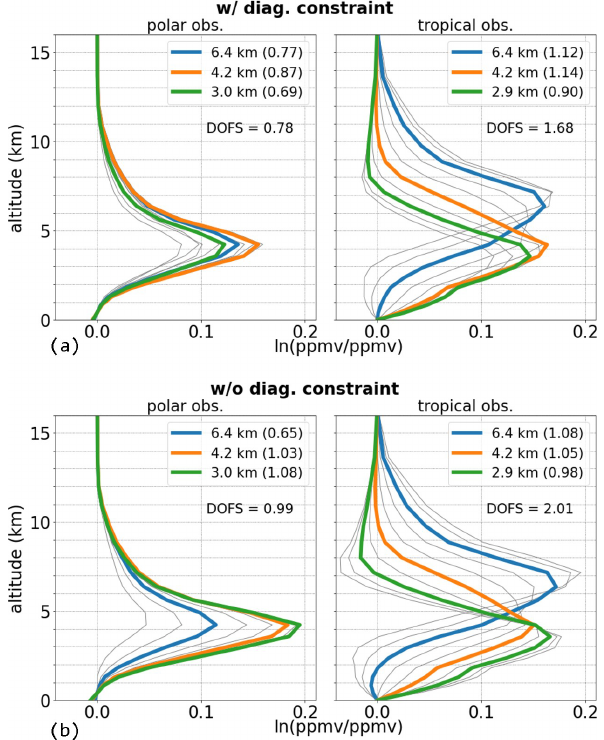
Figure 2. Row averaging kernels for the {H 2 O, δ D} pair product with diagonal constraint (a) and without diagonal constraint (b) . The kernels are shown for a polar observation (83.5 ◦ N, 147.0 ◦ W, left panels in a and b ) and for a tropical observation (4.8 ◦ N, 45.8 ◦ W, right panels in a and b ), both above oceans and measured on 1 July 2017. The measurement response values for the kernels at 3.0, 4.2 and 6.4kma . s . l . are given in the respective parentheses in the